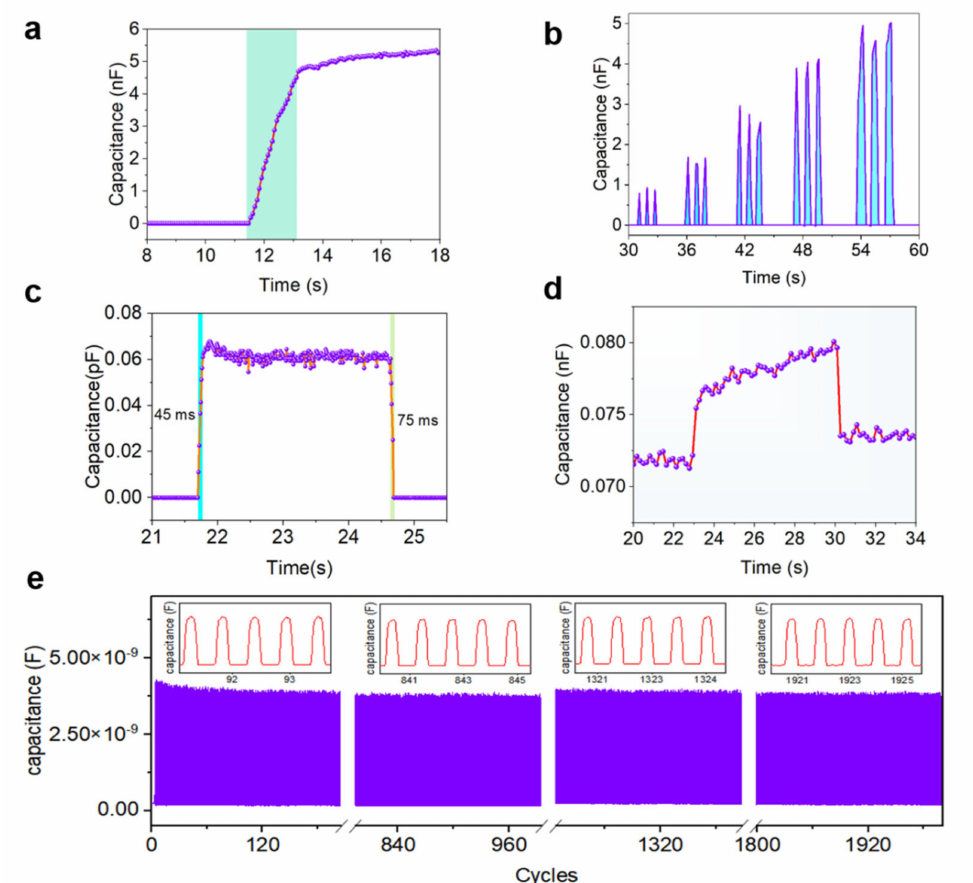
Figure 5. General properties of the iontronic pressure sensors based on digitized construction. ( a ) Typical response behavior of the sensors with a pressure of ≈ 32 kPa gradually applied upon the device. ( b ) Response curve of the pressure sensors when pressures with different intensities are applied on the device repeatedly for three times. The pressure intensities are about 4.8 kPa, 9.1 kPa, 16.0 kPa, 24.4 kPa and 33.4 kPa, respectively. ( c ) Response time and recovery time characterization